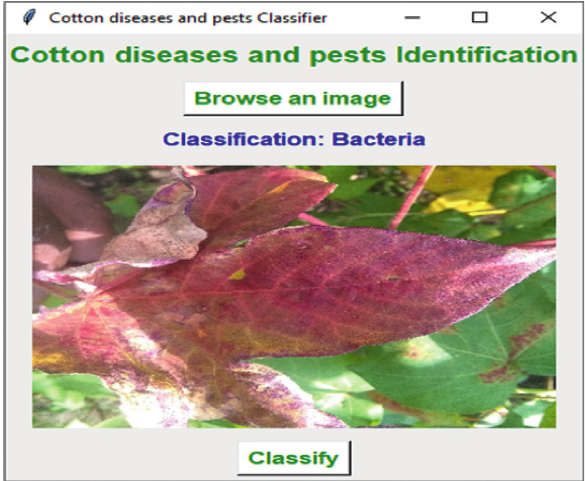
Figure 3: Cotton disease and pest identification prototype iden- tified as bacteria.